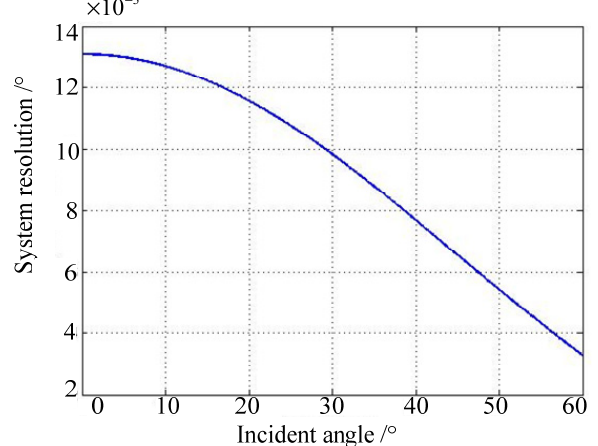
Figure 8. System resolution with respect to the incident